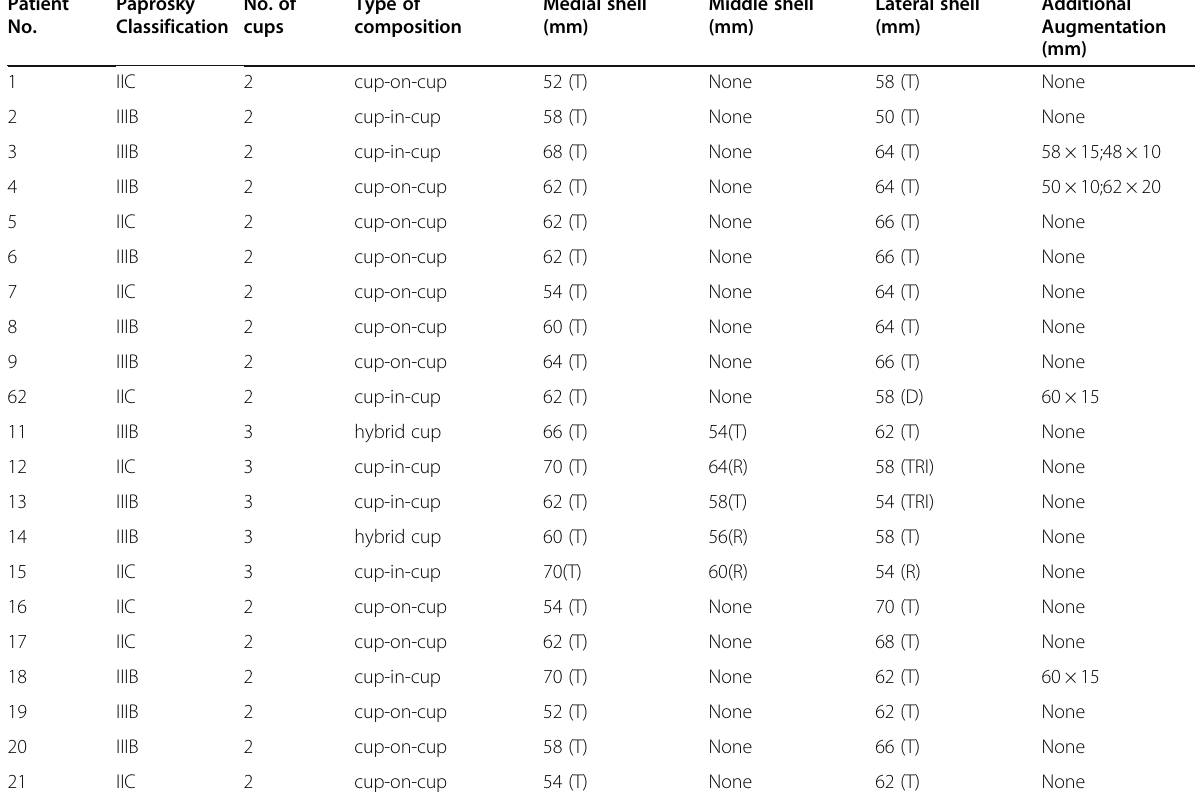
Table 2 The information of used implants in current study Patient Paprosky No. of No. Classification